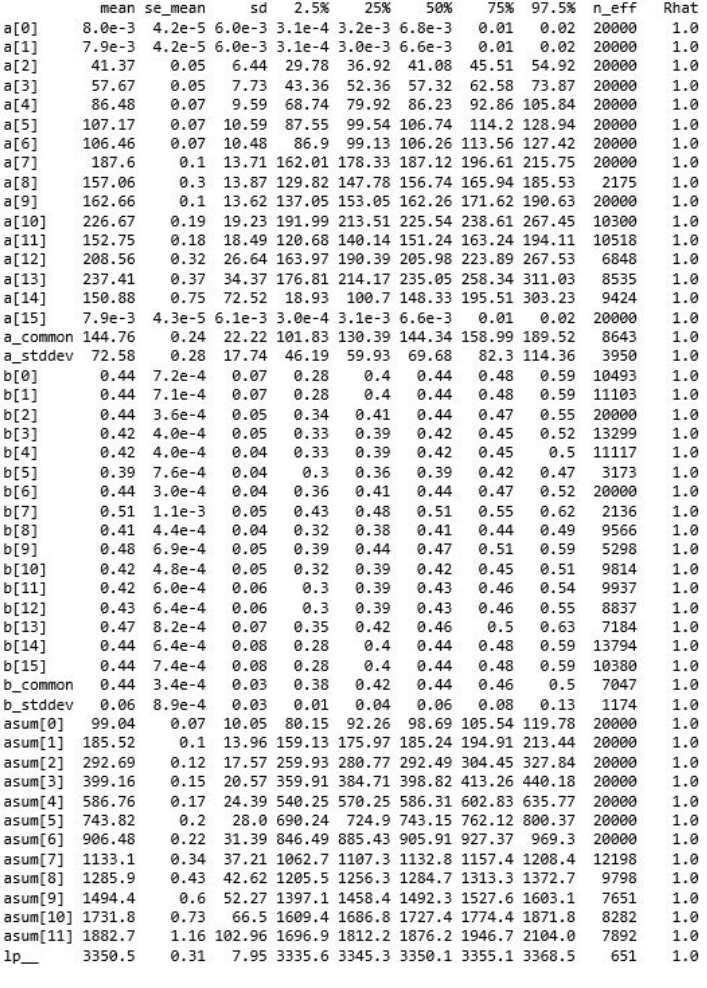
Figure 5. Inference and diagnostics for the software reliability prediction model. Diagnostics are explained in the text and follow [31]. Here, a is total number of bugs, b is the bug finding rate and asum relates to the number of future